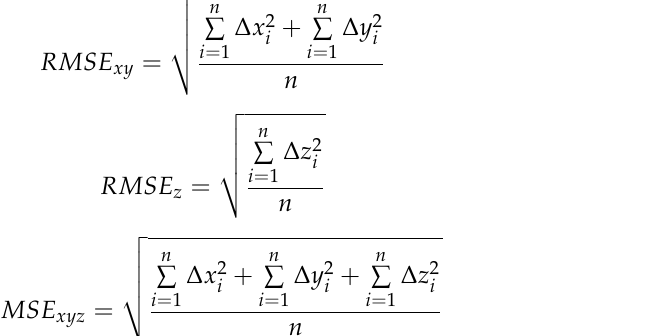
Figure 6. The detailed arrangement of the checkpoints (Unit: m).